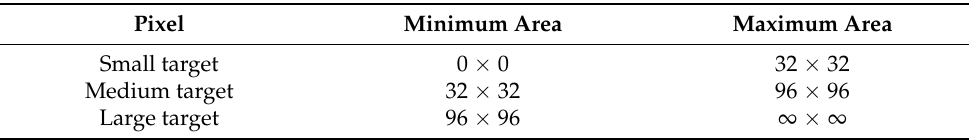
Table 1. Definition of large, medium, and small targets in MS